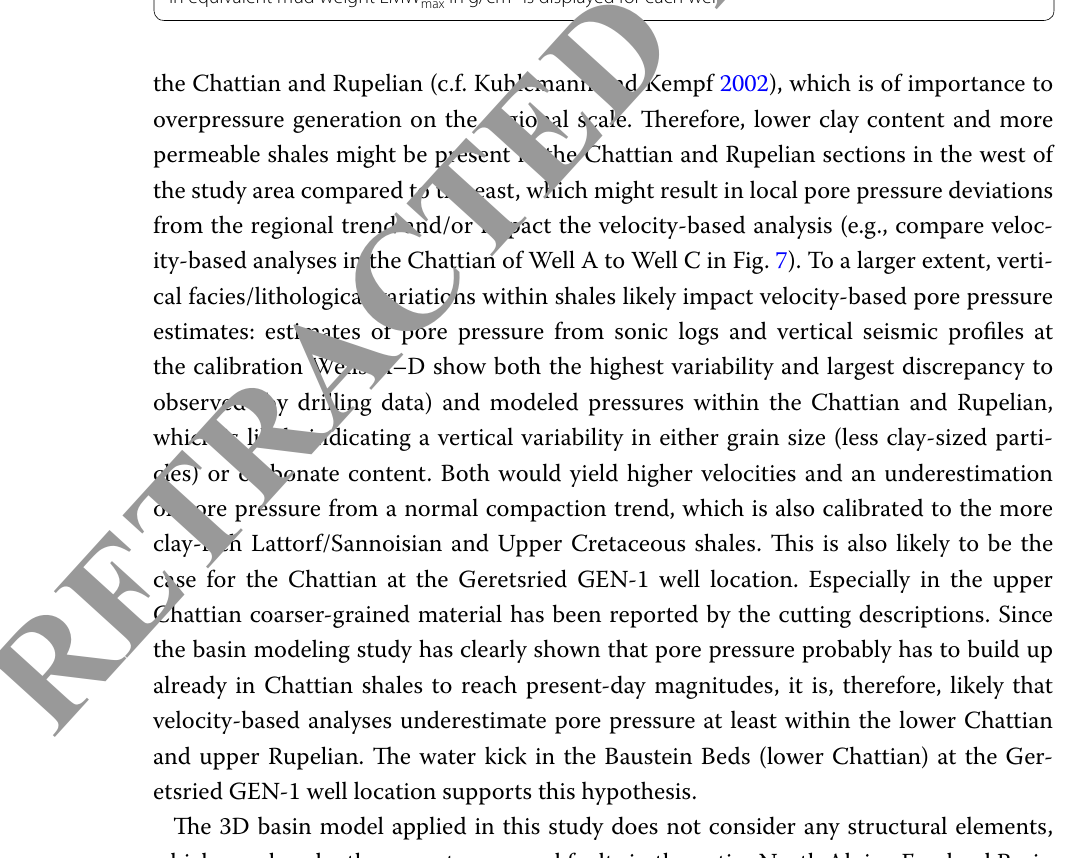
Fig. 10 Non-decompacted sedimentation rates (thickness divided by time interval) for Cenozoic strata from tops of the calibration wells and the Geretsried GEN-1 well. In addition, the maximum observed pore pressure in equivalent mud weight EMW max in g/cm 3 is displayed for each